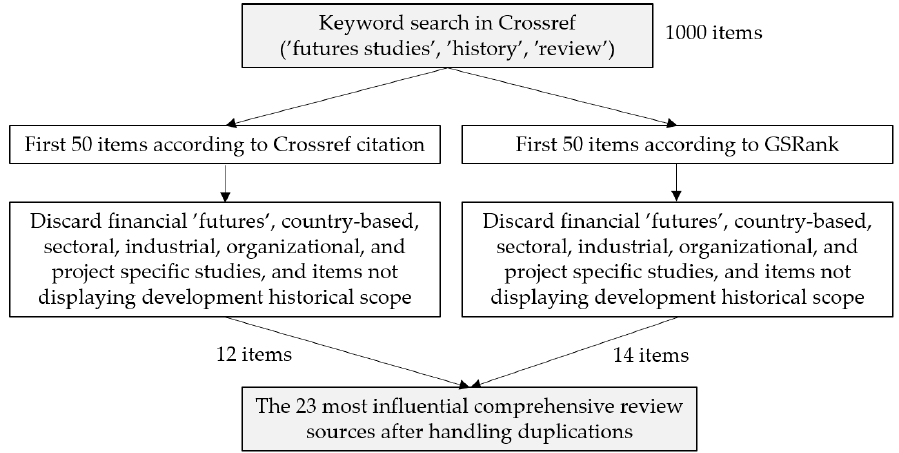
Figure 1. The process of the systematic literature review.